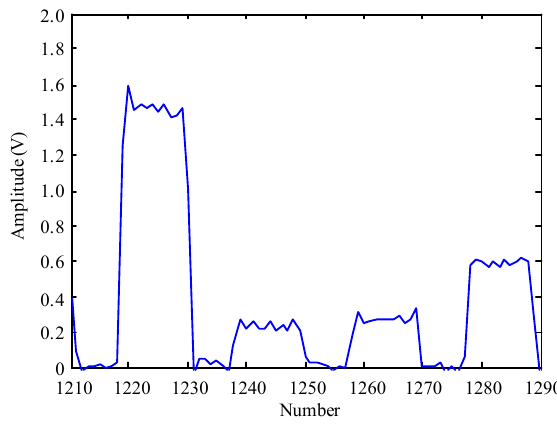
Fig. 6 Interference signal local